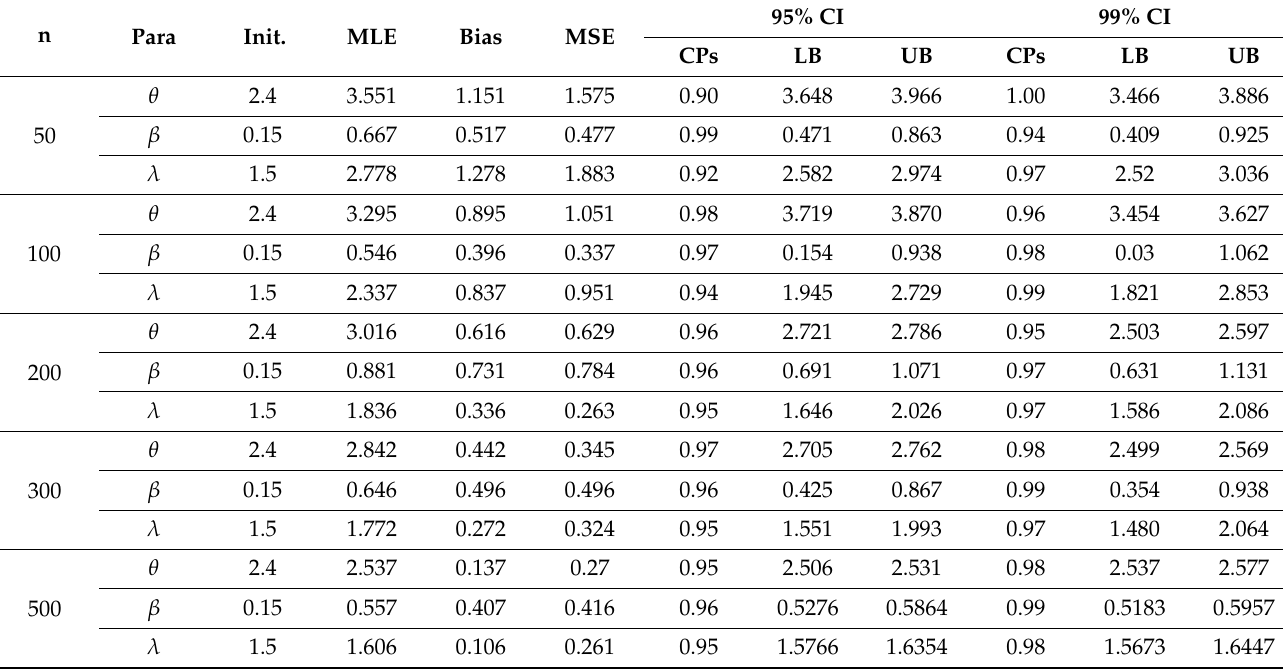
Table 4. The MLEs, Bias, MSE, and CPs for the model parameters of the minLLx distribution based on some initial (Init) values.